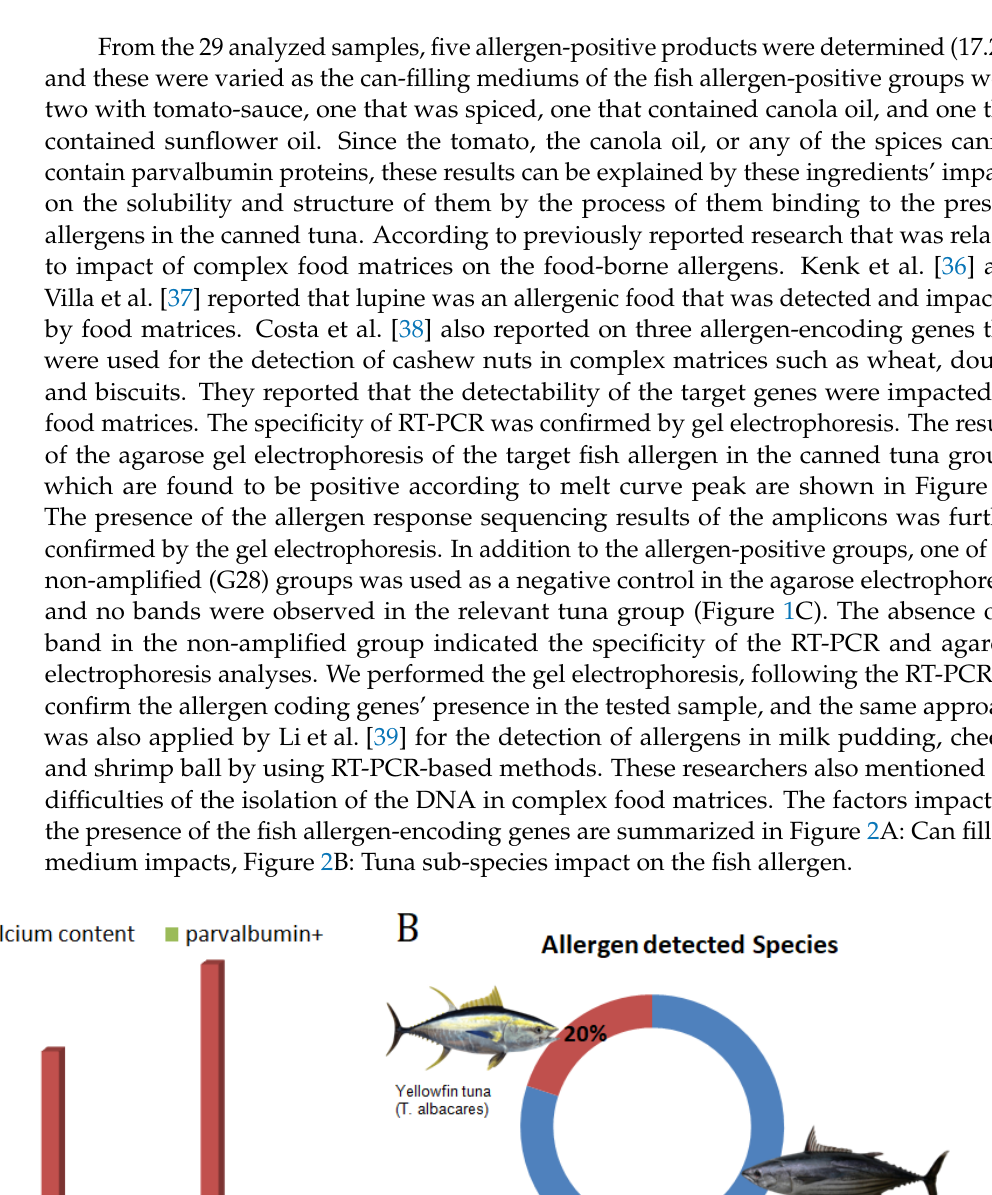
Figure 2. ( A ) Can-filling medium impact on pH, calcium level, and allergen response. ( B ) species distribution impact on the fish allergen.